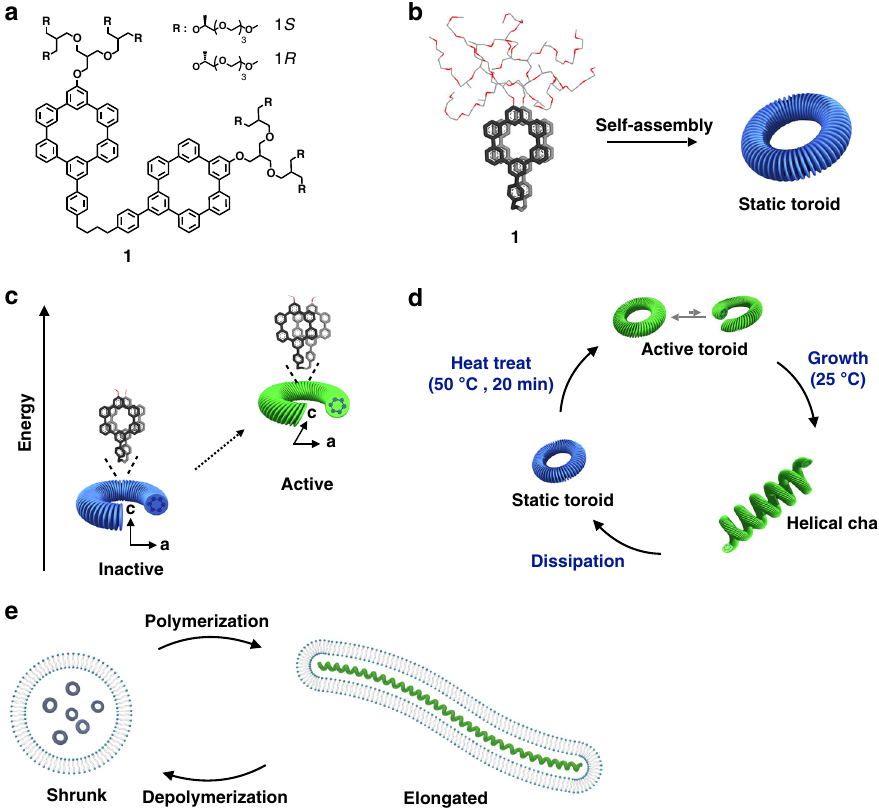
Fig. 1 Dissipative helical polymers fueled by heat stress. a Molecular structure of aromatic macrocycle 1. b Schematic representation of the toroidal assembly of 1 with an eclipsed conformation. c Activation of the toroids with a tilting transition by applying heat stress as an energy source. d Schematic representation of the helical polymerization and depolymerization cycle of the toroids upon heat treatment. e Schematic representation of elongation/ contraction motion of the lipid vesicle encapsulating toroids driven by polymerization and depolymerization